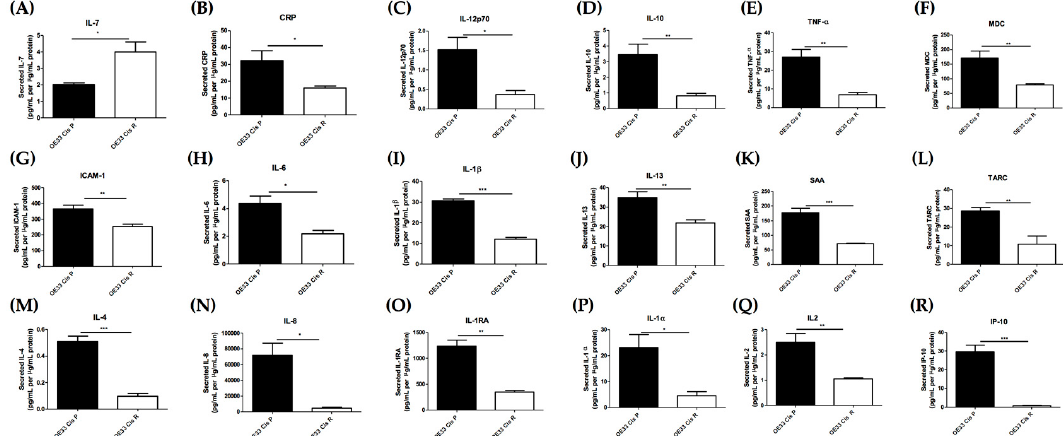
Figure 4. Inflammatory protein secretions are significantly different in cisplatin-sensitive (OE33 Cis P) versus cisplatin-resistant (OE33 Cis R) OAC cells. The secreted levels of 47 proteins in Cis P and Cis R cells was evaluated by multiplex ELISA; 23 proteins were detected in supernatant of Cis P and Cis R cells; 18 proteins were significantly different between the two cell lines, and interleukin-7 was significantly higher in Cis R cells compared to Cis P cells. Secreted levels of ( A ) Interleukin-7 (IL-7) ( B ) C-reactive protein (CRP) ( C ) Interleukin 12p70 (IL-12p70) ( D ) Interleukin 10 (IL-10) ( E ) Tumour necrosis factor α (TNF- α ) ( F ) Macrophage-derived chemokine (MDC) ( G ) Intracellular adhesion molecule 1 (ICAM-1) ( H ) Interleukin 6 (IL-6) ( I ) Interleukin 1 β (IL-1 β ) ( J ) Interleukin 13 (IL-13) ( K ) Serum amyloid A (SAA) ( L ) Thymus and activation regulated chemokine (TARC) ( M ) Interleukin 4 (IL-4) ( N ) Interleukin 8 (IL-8) ( O ) Interleukin 1 receptor antagonist (IL-1RA) ( P ) Interleukin 1 α (IL-1 α ) ( Q ) Interleukin 2 (IL-2) ( R ) Interferon gamma-induced protein 10 (IP-10) in OE33 Cis P and OE33 Cis R cells, all secretions normalised to protein content. (n = 4). Unpaired t -test. * p < 0.05, ** p < 0.01, *** p < 0.001. Date expressed as ± SEM.